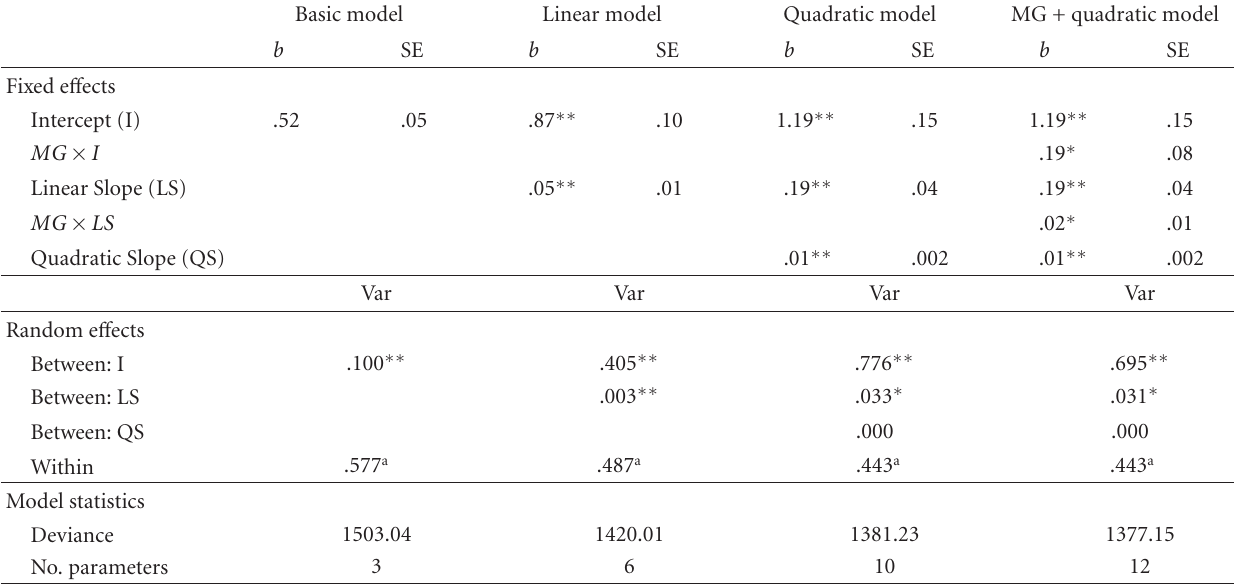
Table 2: Analysis of change in test-related cognitions prior to test completion.